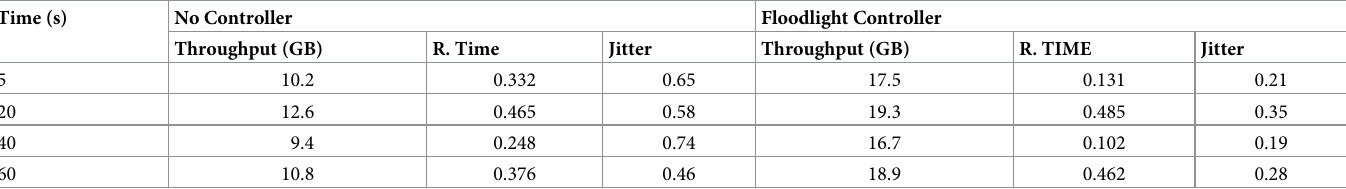
Table 3. The average results after evaluating the QOS measures in wireshark across the Eight (8) hosts.